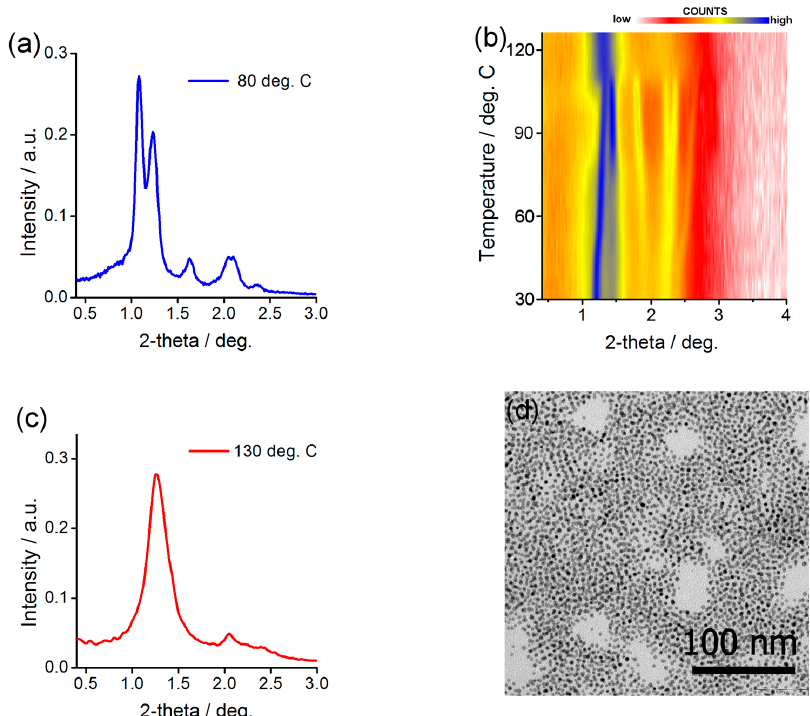
Figure 6. Structural investigation of Ag@L1/CF nanoparticles. ( a , c ) SAXRD profiles for low and high temperature structures (panels a, c, respectively) ( b ) Temperature evolution of SAXRD patterns taken for annealed sample and ( d ) corresponding TEM image.